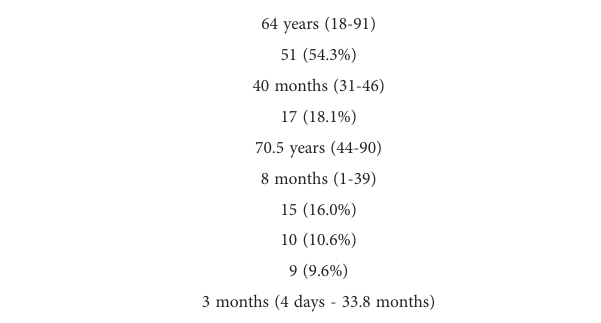
TABLE 3 Demographics, sample sizes and follow up times in all